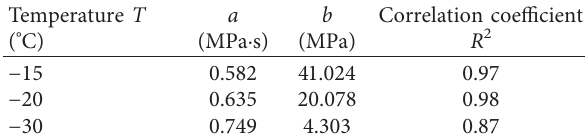
Table 4: Fitting parameters for the peak stress and the strain rate.